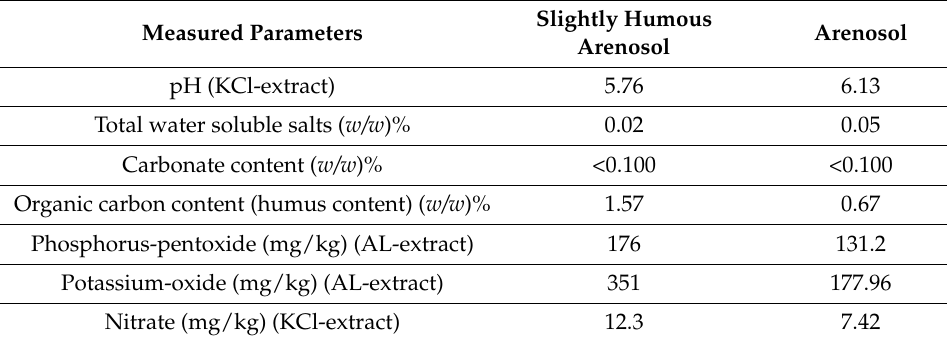
Table 2. Characteristics of the soils used for the